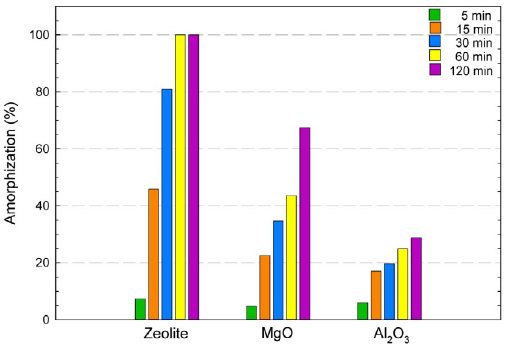
Fig. 2 XRD analysis of mechanically activated powder mixture for 5, 15, 30, 60, and 120 min. Fig. 3 Amorphization degree diagram of the